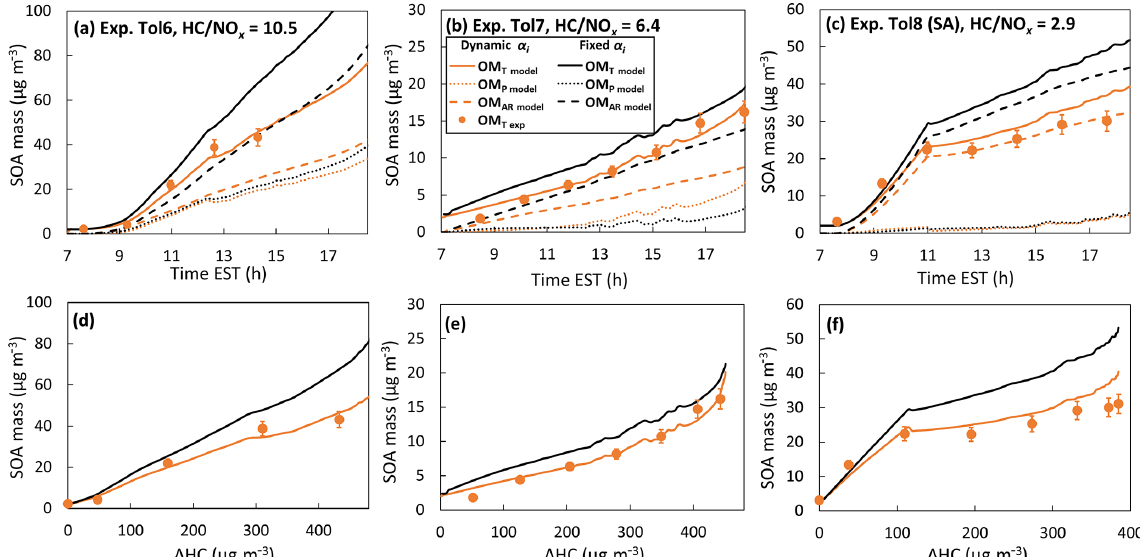
Figure 3. Comparison between simulated SOA mass using the fixed α i ( α i is obtained when precursor being consumed make up half of the total simulated consumption) and dynamic α i ( α i evolving as photooxidation) under (a) low-NO x condition (Exp. Tol6, HC / NO x = 10.5), (b) moderate-NO x condition (Exp. Tol7, HC / NO x = 6.4), and (c) high-NO x condition (Exp. Tol8, HC / NO x = 2.9 with sulfuric acid (SA)- seeded aerosol). (d, e, f) represent the time-dependent SOA growth curve (SOA mass concentration against consumed HC in the unit of µgm − 3 ) corresponding to the experimental conditions of (a, b, c) , respectively. The solid circle represents the experimental measurements. The SOA mass is corrected for particle loss to the chamber wall. The experimental conditions are available in Table